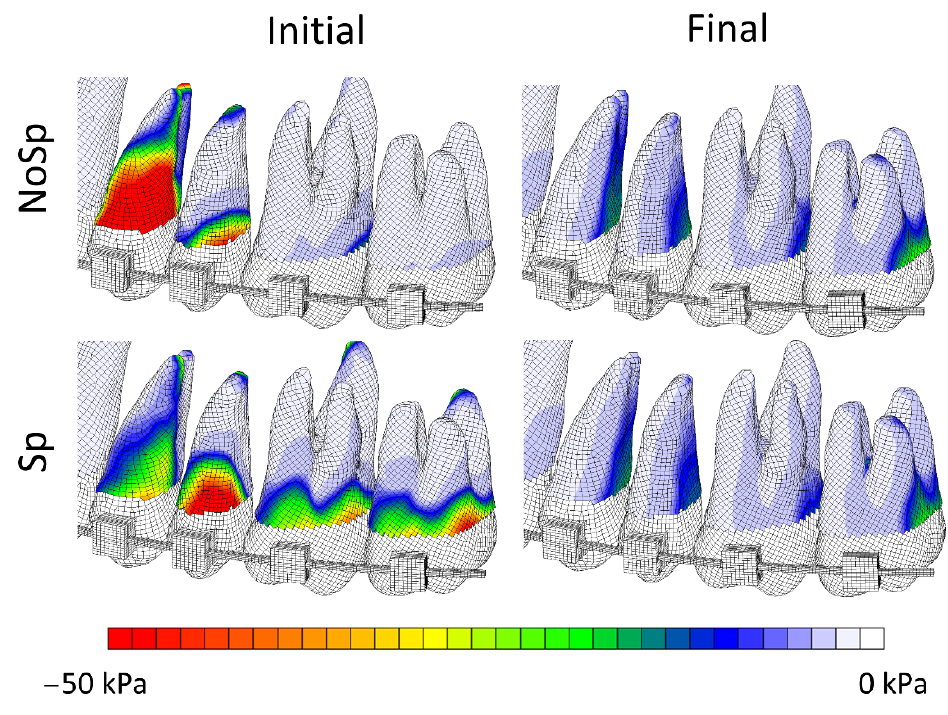
Figure 8. Distribution of compressive stress in the PDL at the initial and final steps. Higher compressive stress was observed in the initial displacement (left). A large, highly compressed region existed at the first premolar in the NoSp model.